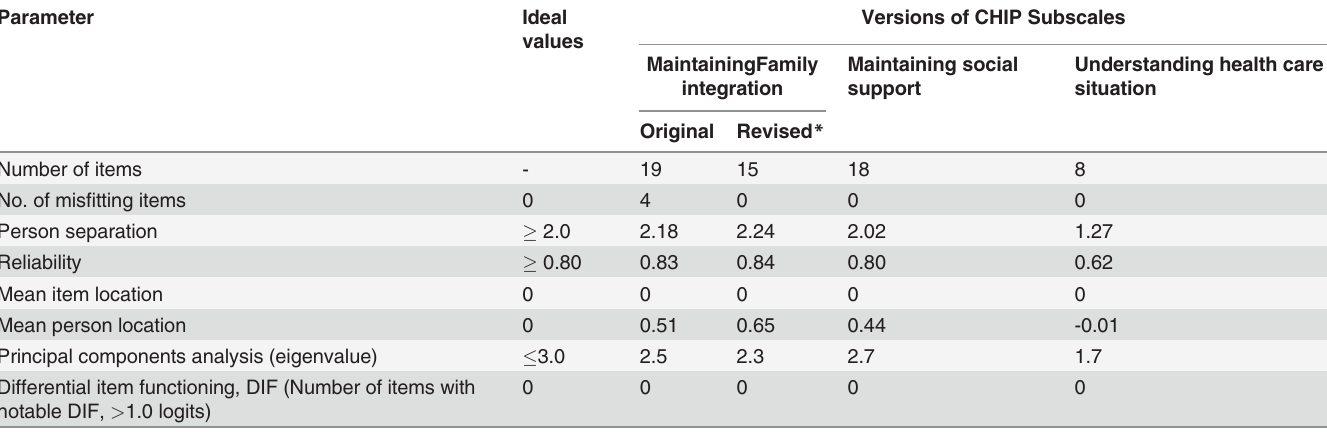
Table 3. Overall performance of the CHIP Subscales in parents of children with